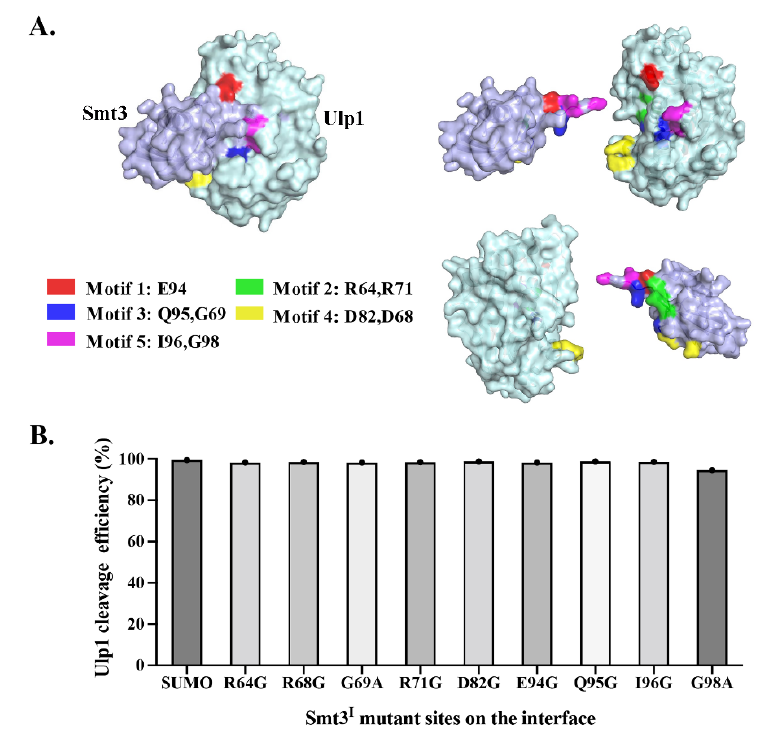
Figure 3. Analysis of Ulp1 against Smt3 I mutants. ( A ) Interface of Ulp1–Smt3 in the complex structure (PDB,1euv). The motif and corresponding residues in Smt3 have been labeled with different colors. ( B ) Evaluation of Ulp1 cleavage against different Smt3 variants in YESS–PSSC system. Cleavage activity of Ulp1 against Smt3 I substrates are presented as average cleavage efficiency ( n = 3 independent experiments).